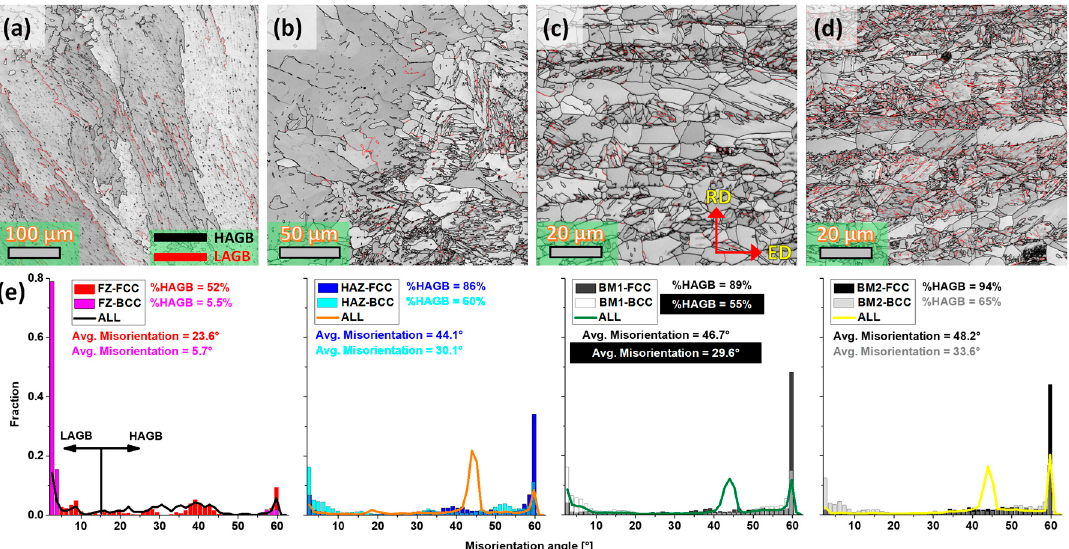
Figure 6 . IQ imagens together with the grain boundaries for the different analyzed zones. ( a ) FZ, ( b ) fusion line between the FZ and HAZ, ( c ) BM1, ( d ) BM2, and ( e ) misorientation angle distributions for all the phases in all the analyzed zones.